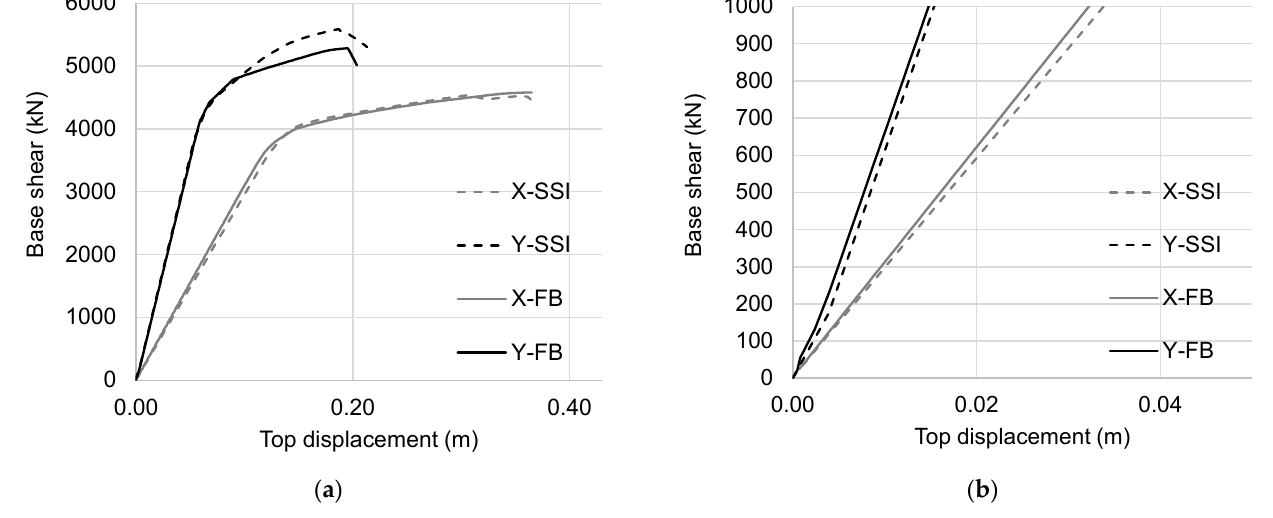
Figure 13. Capacity curves ( a ) full range and ( b ) only linear-elastic part.